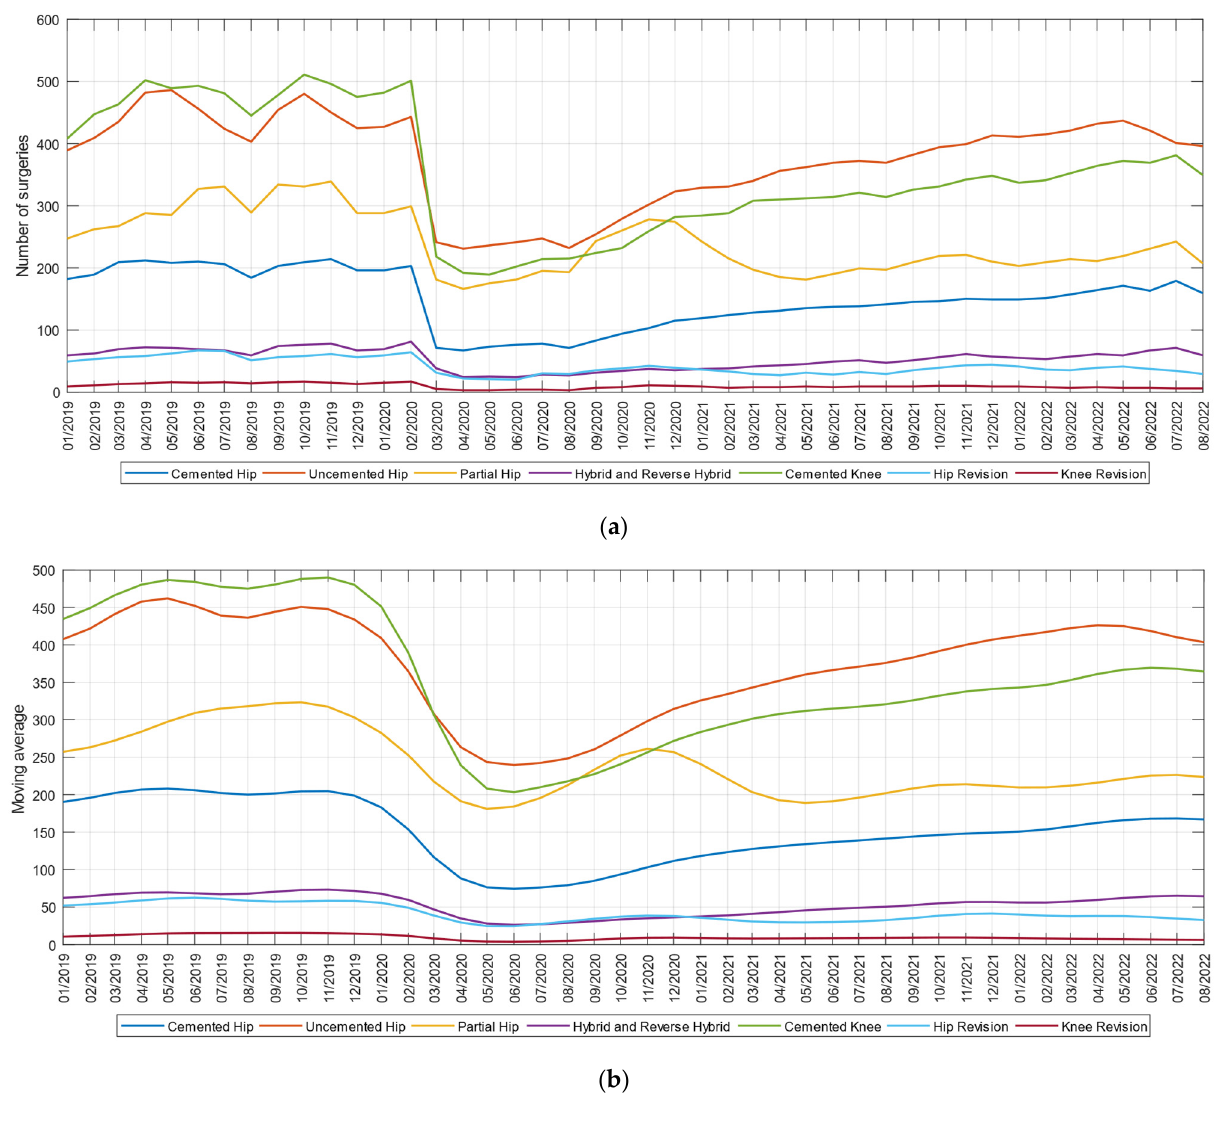
Figure 1. ( a ) Monthly volume; and ( b ) 3-month moving average in period 1st January 2019–1st September 2022: cemented hip, uncemented hip, partial hip, hybrid and reverse hybrid, cemented knee, revision knee, and revision hip.